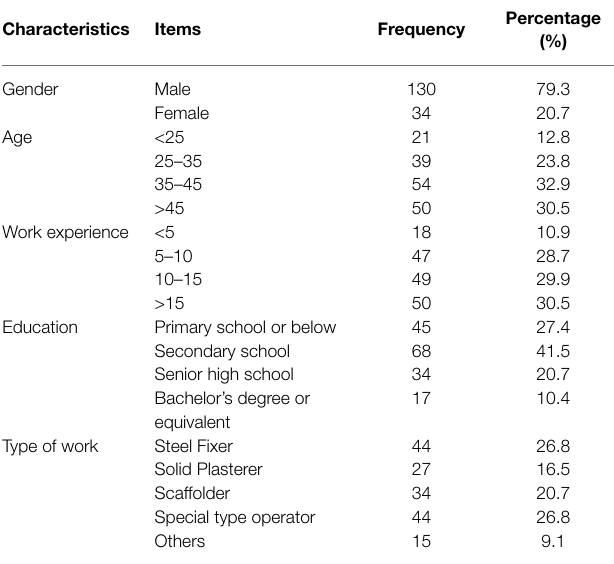
TABLE 3 | Demographic characteristics of construction workers ( n = 164). Characteristics Items